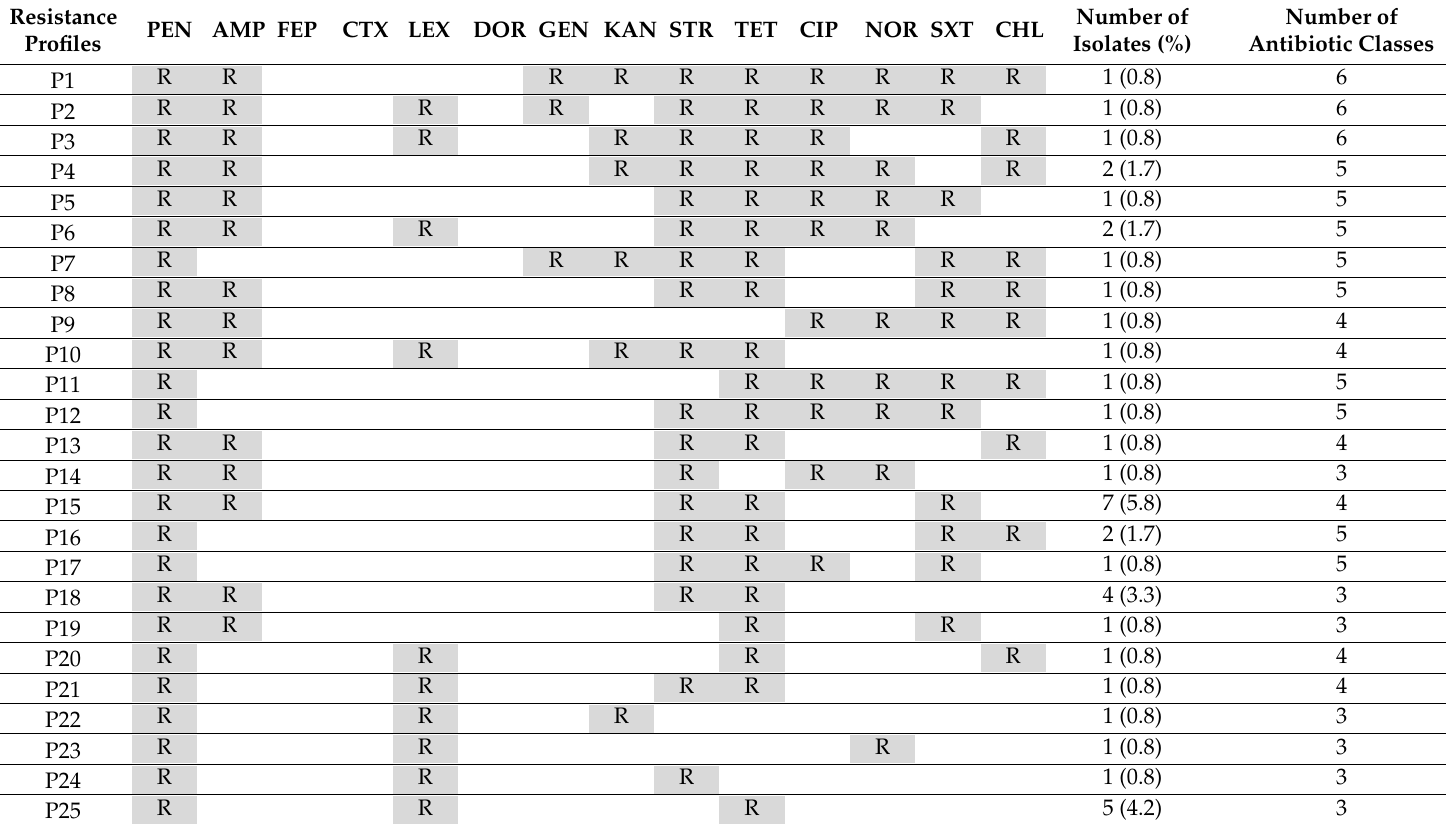
Table 1. Antibiotic resistance profile of E. coli isolated from raw minced meat in Lebanon. Antibiotics in the resistance profile were arranged according to the order of antibiotics / classes listed in the Clinical and Laboratory Standards Institute (CLSI) guidelines. Penicillin (PEN), ampicillin (AMP), cefepime (FEP), cefotaxime (CTX), cephalexin (LEX), doripenem (DOR), gentamicin (GEN), kanamycin (KAN), streptomycin (STR), tetracycline (TET), ciprofloxacin (CIP), norfloxacin (NOR), trimethoprim-sulfamethoxazole (SXT), and chloramphenicol (CHL). All isolates were susceptible to amoxicillin / clavulanic acid (AMC), cefixime (CFM), meropenem (MEM), and imipenem (IPM), so these antibiotics were not listed in the table. Shaded (grey) cells with the letter R indicate